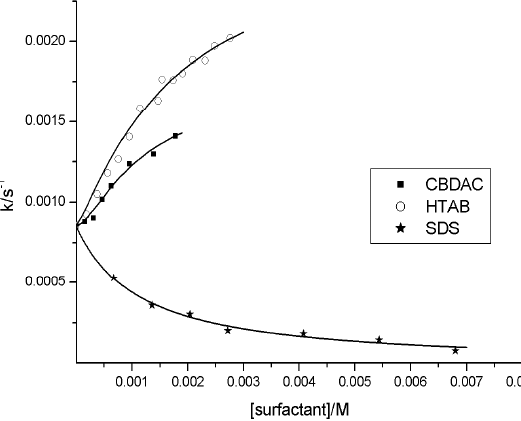
Figure 3. Integral kinetic curves for malachite green fading in the presence of SDS. Figure 4. Best fit of equation (4) on k = f([surfactant])